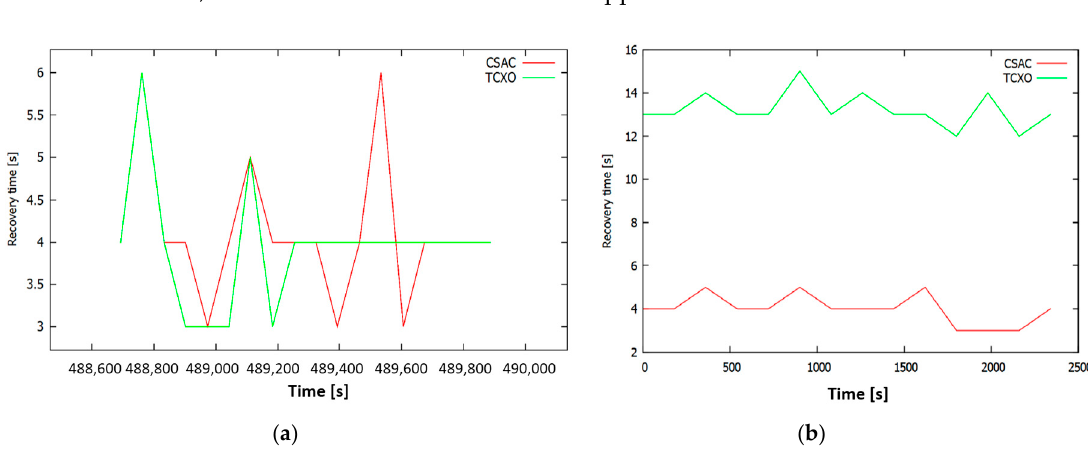
Table 7. Holdover values.